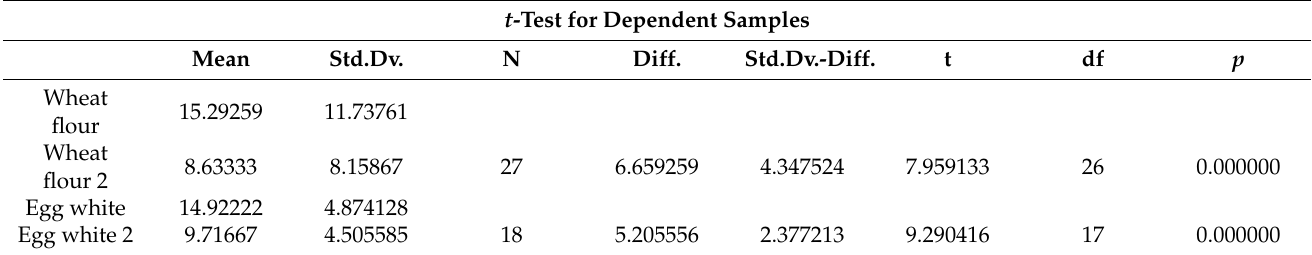
Table 3. Comparison of dynamic mean values for specific IgE of wheat flour and egg white. t -Test for Dependent Samples